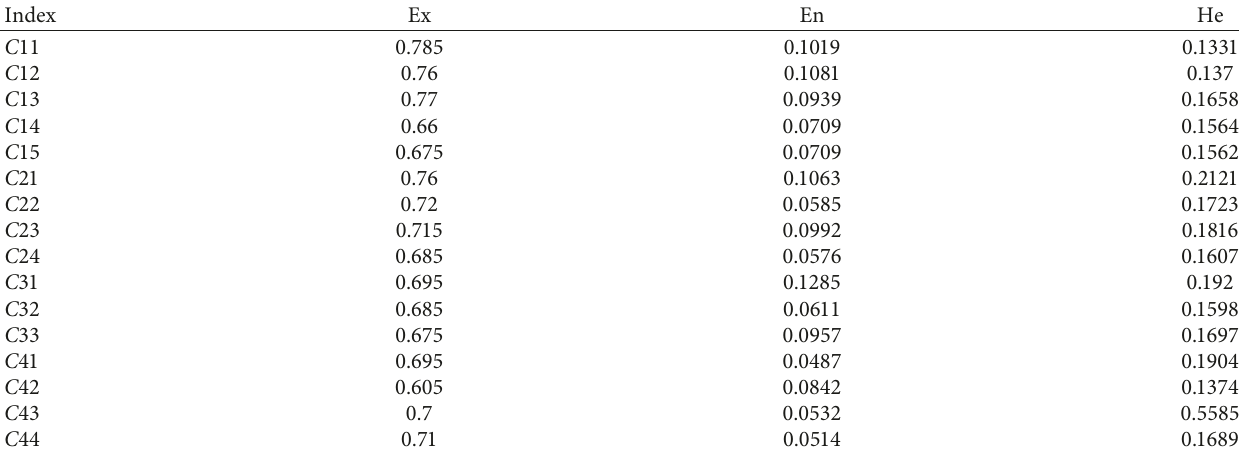
Table 13: Cloud digital characteristics of the second-level